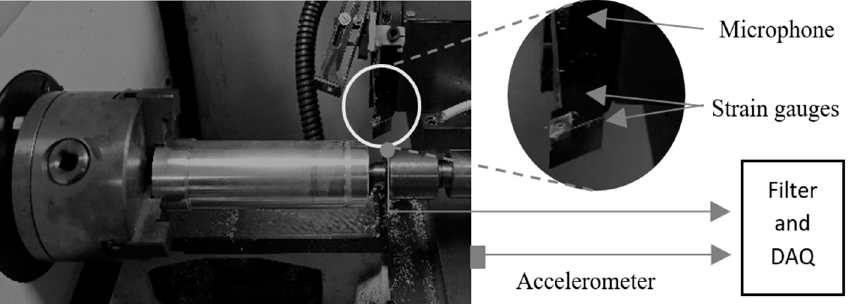
Figure 1. Experimental apparatus. Table 1. Sensors, characteristics, and